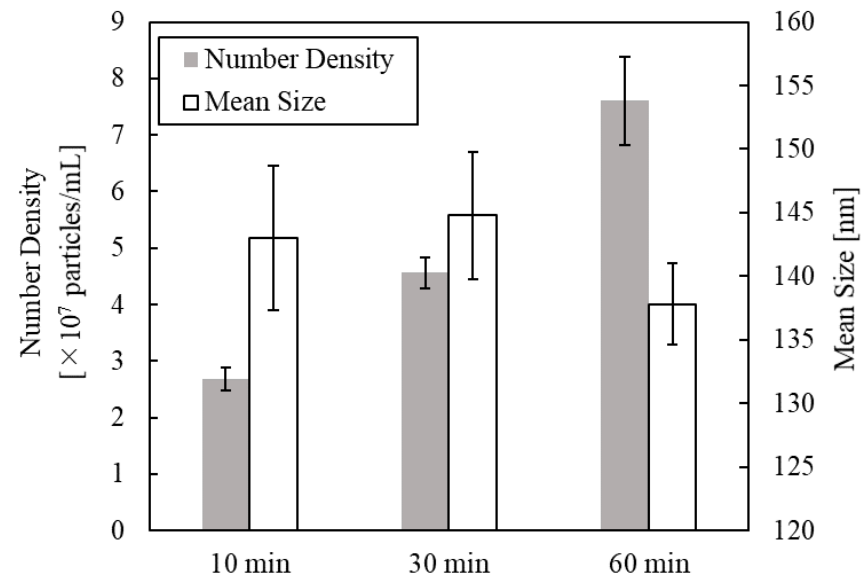
Figure 2. Total number densities (gray bars) and mean sizes (white bars) of the UFBs in solutions subjected to 10, 30, and 60 min of bubbling time (error bars indicate standard error).